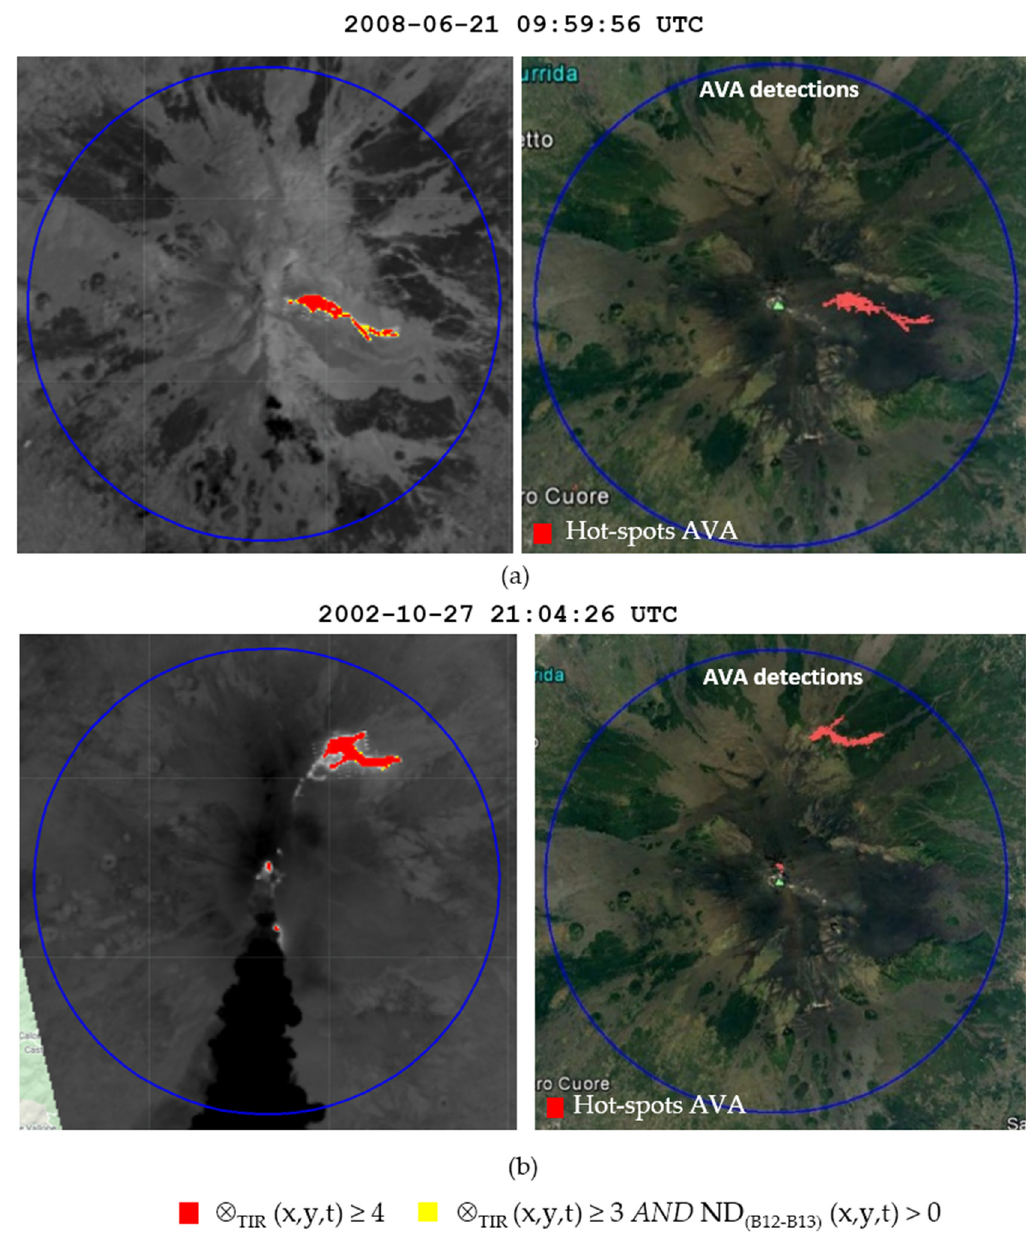
Figure 3. Thermal anomalies detected on ASTER scenes during the Mt. Etna flank eruptions of ( a ) 21 June 2008 and ( b ) 27 October 2002 by RASTer (left side) and AVA (right side). Hotspots detected by RASTer are depicted as in Figure 2. The hotspots detected by AVA are depicted in